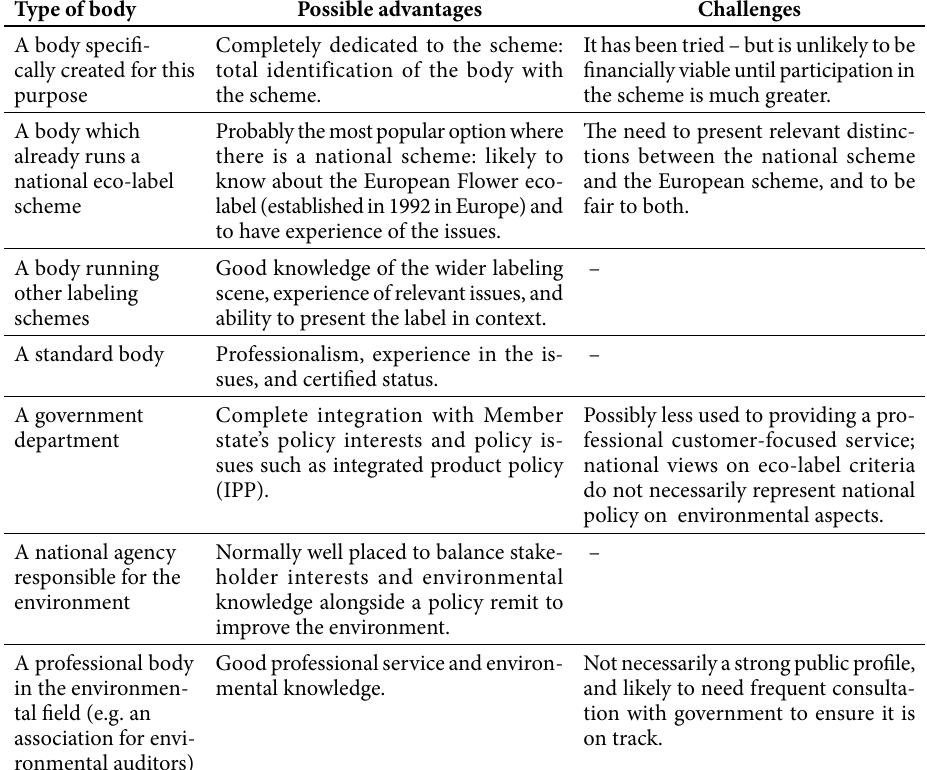
Fig. 6. Eco-labeling policy formation on various economic